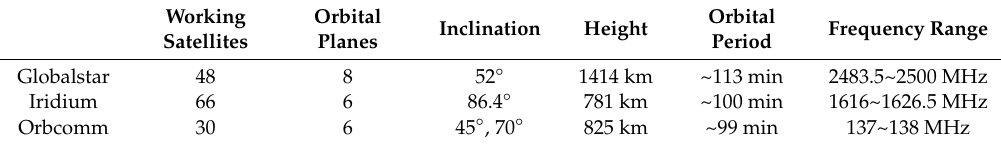
Table 1. Specifications of Orbcomm, Globalstar, and Iridium LEO satellites.